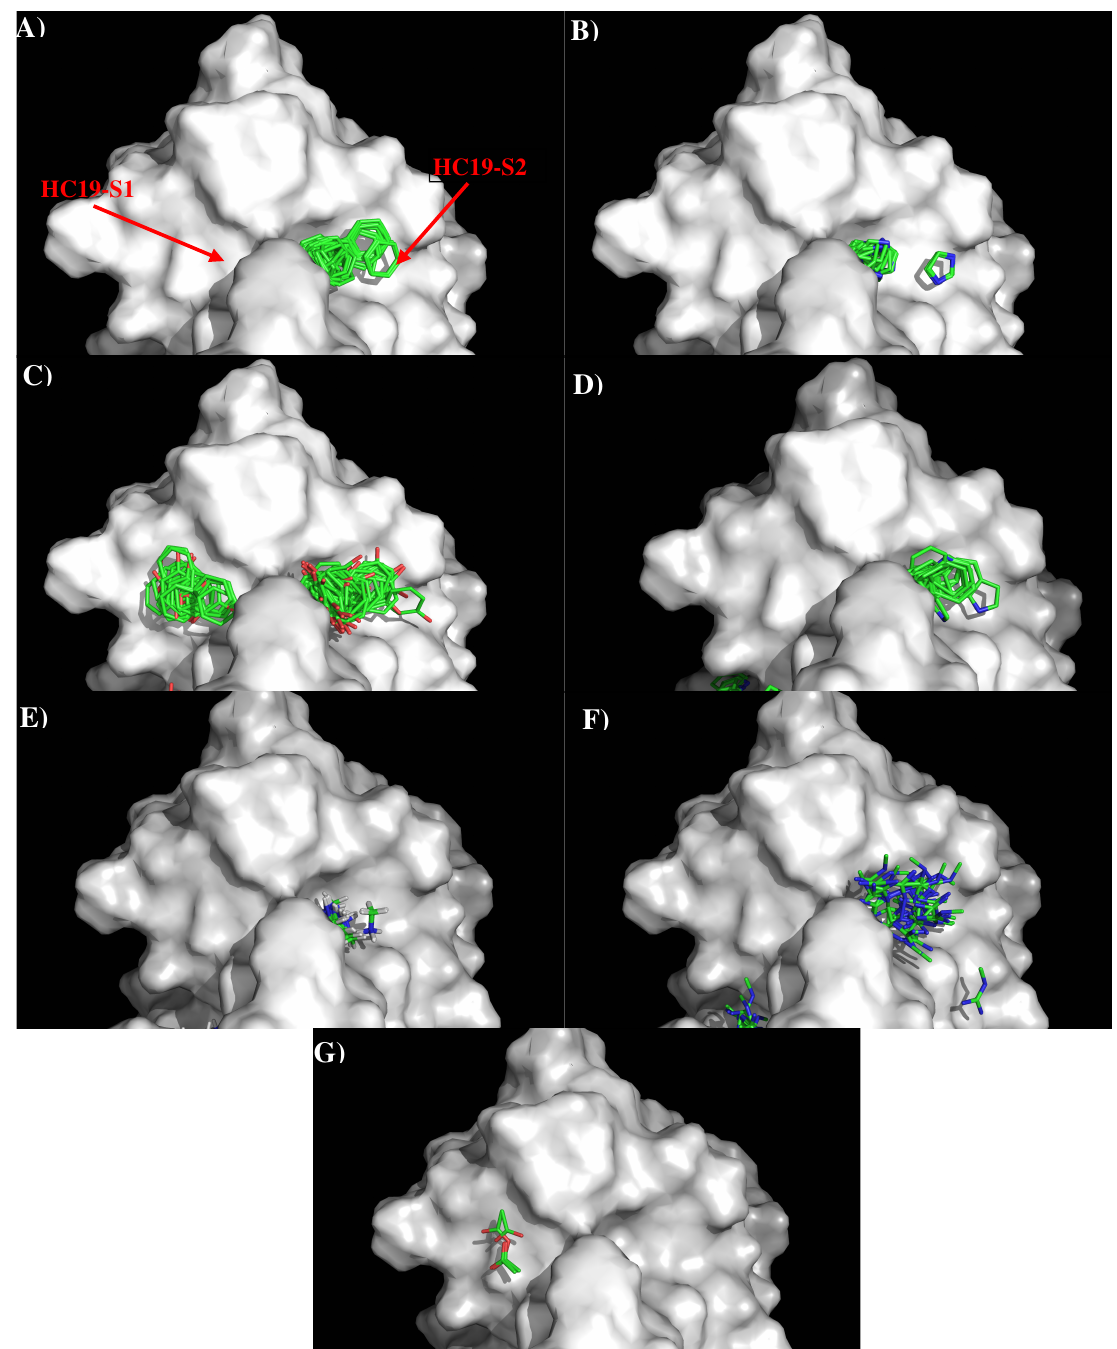
Figure 2. Selected MCSS minima of functional groups on the surface of antibody HC19. ( A ) BENZ; Figure 2 ( B ) IMIA; ( C ) PHEN; ( D ) INDO; ( E ) MAMM; ( F ) MGUA; ( G ) ACET. Figures were prepared